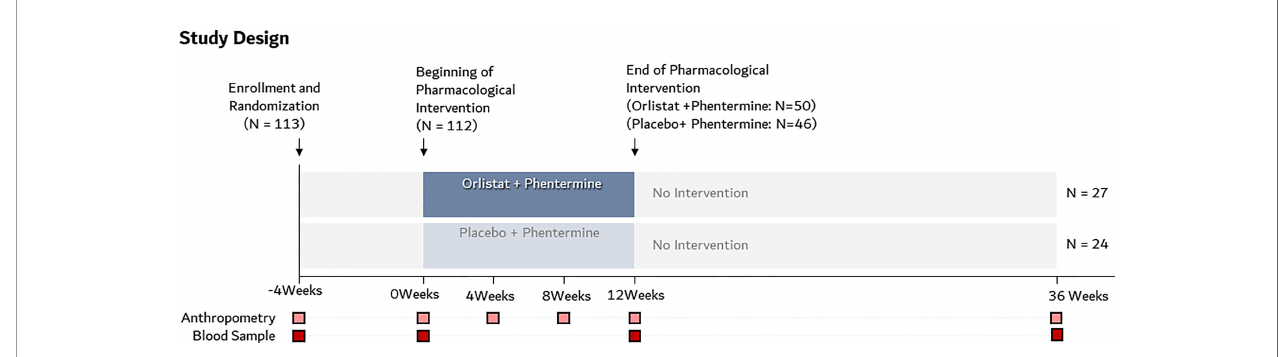
FIGURE 1 | Study design schematic of the intervention and